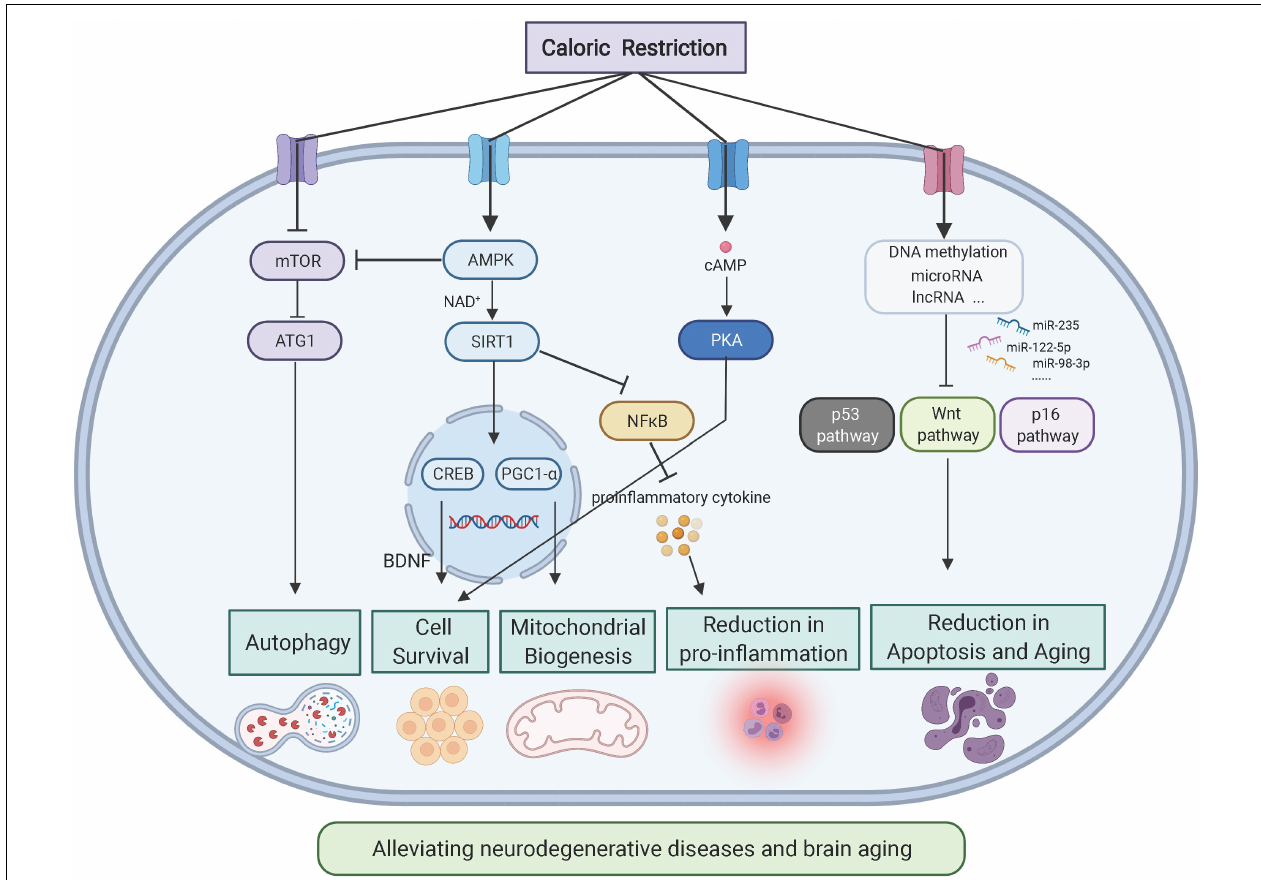
FIGURE 1 | Relationship between aging/neurodegenerative diseases and the brain microenvironment (Created with BioRender.com). Multiple factors, such as neuroinflammation or permeability of the blood-brain barrier (BBB), may interact with the brain microenvironment to impact the progression of brain aging or neurodegenerative diseases. Such pathological changes can be attributed to the epigenetic mechanisms of metabolic waste. TBI, traumatic brain injury; MS, multiple sclerosis; AD, Alzheimer’s disease; PD, Parkinson’s disease; HD, Huntington’s disease; and ALS, amyotrophic lateral